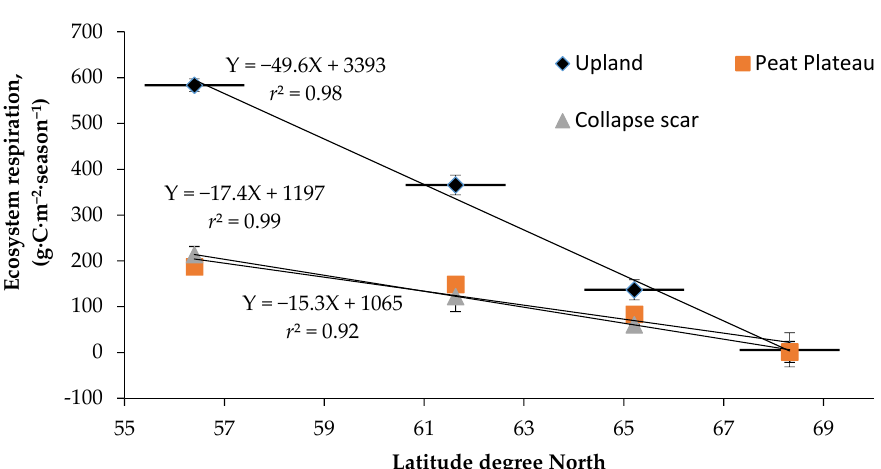
Figure 8. Seasonal net carbon exchange (NCE) for different sites and landform positions. MATT (°C) is mean annual air temperature.